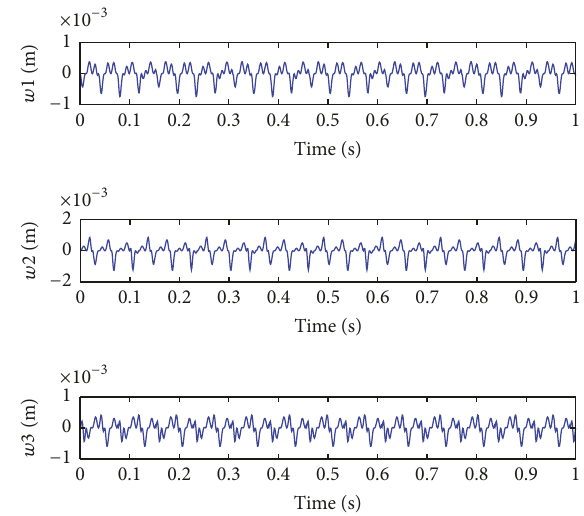
Figure 3: Vibration response curves of the end of the flexible intermediate links.